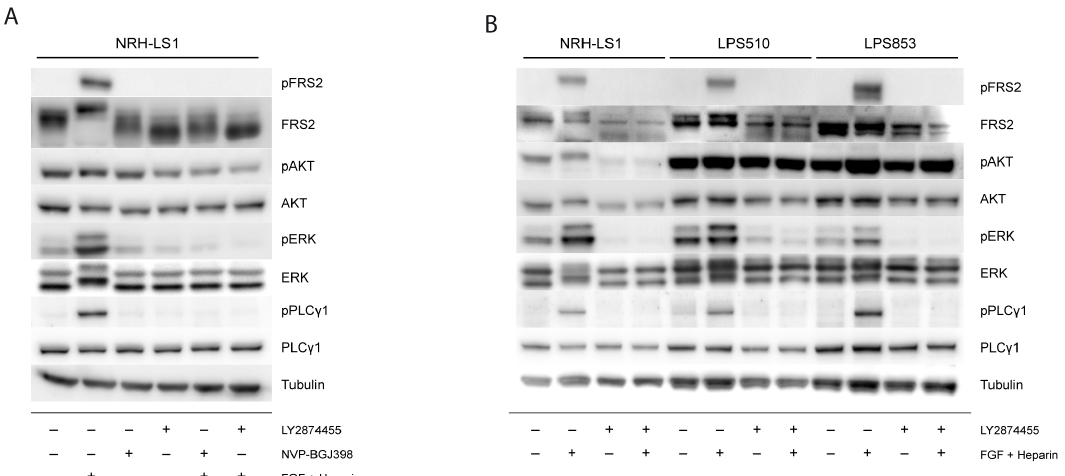
Figure 4. Signaling pathway analysis after FGFR stimulation and inhibition in NRH-LS1, LPS510 and LPS853. Western blots showing ( A ) The level of phosphorylated and total protein for the indicated proteins in NRH-LS1 cells treated for 24 h with 100 nM of LY2874455 or 100 nM NVP-BGJ398, with or without FGF stimulation as indicated; ( B ) The level of phosphorylated and total protein for the indicated proteins in NRH-LS1, LPS510 and LPS853 cells treated for 24 h with 100 nM of LY2874455, with or without FGF as indicated. In all Western blot experiments α -tubulin was used as a loading